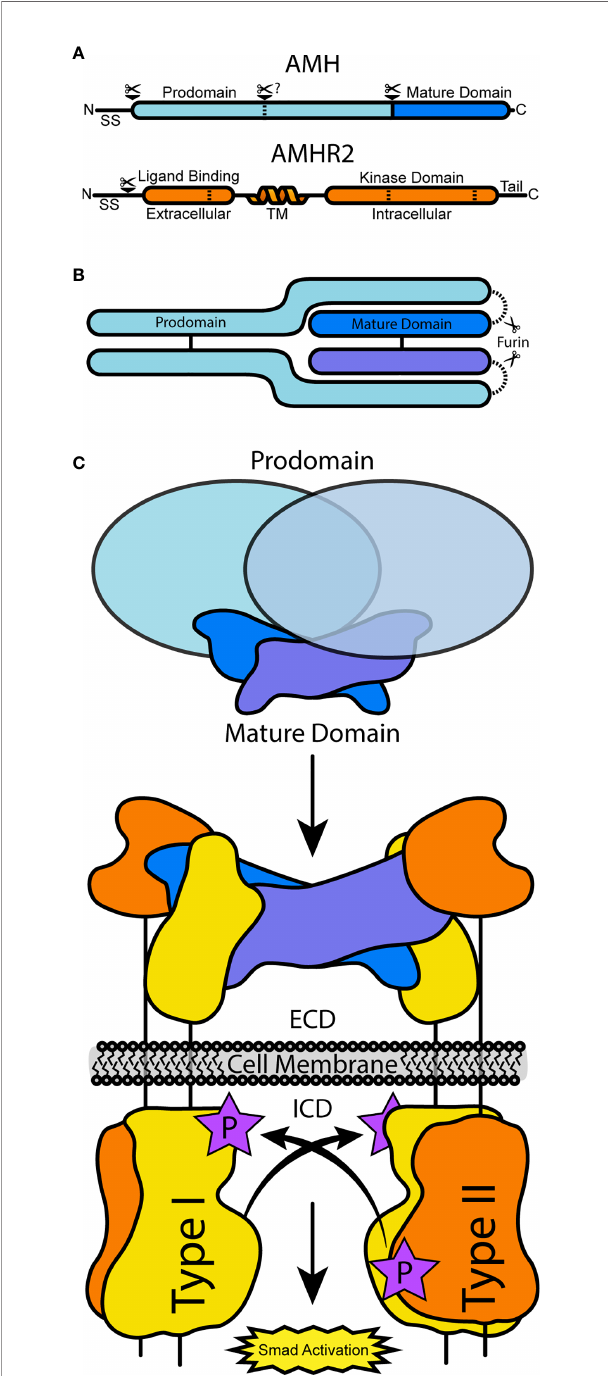
FIGURE 1 | A schematic of AMH and AMHR2 processing and receptor assembly. (A) The full translated sequences of AMH and AMHR2 undergo processing to cleave the signal sequence. In AMH, PCs will cleave at the solid bar, separating the prodomain and mature domain, while alternative processing may occur at the dashed bar. In AMHR2, dashed bars represent alternative splicing sites. (B) Assembled AMH pro-complex, which may or may not be cleaved. (C) AMH-driven receptor assembly at the cell surface, resulting from AMH binding AMHR2 and prodomain dissociation. Type I receptors are activated and in turn activate BMP